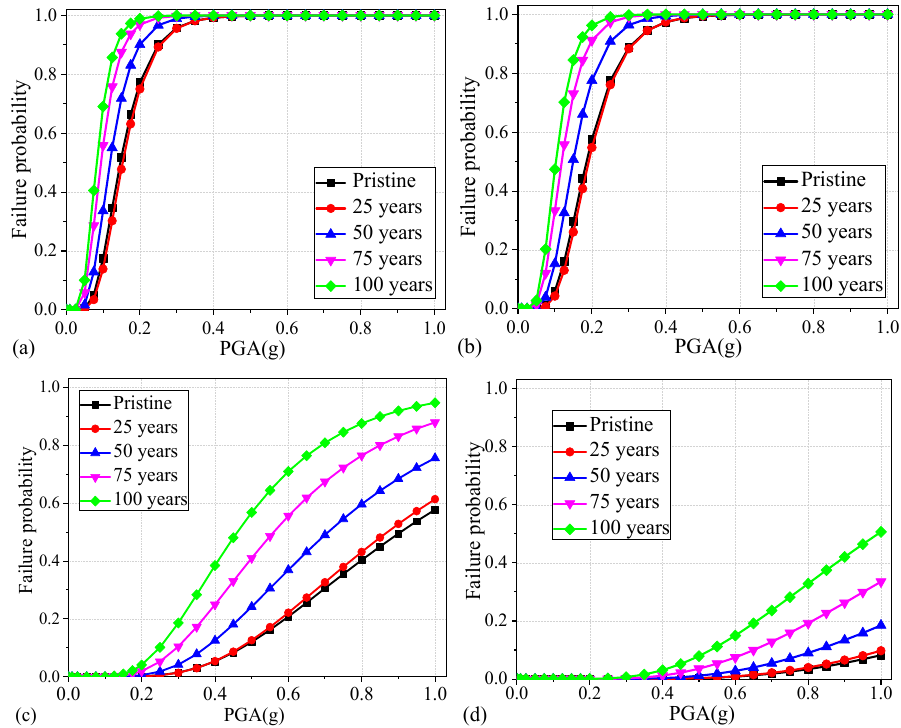
Figure 12. Time-dependent seismic fragility curves of RC columns at different damage states: ( a ) slight; ( b ) moderate; ( c ) extensive; and ( d ) complete damage states.